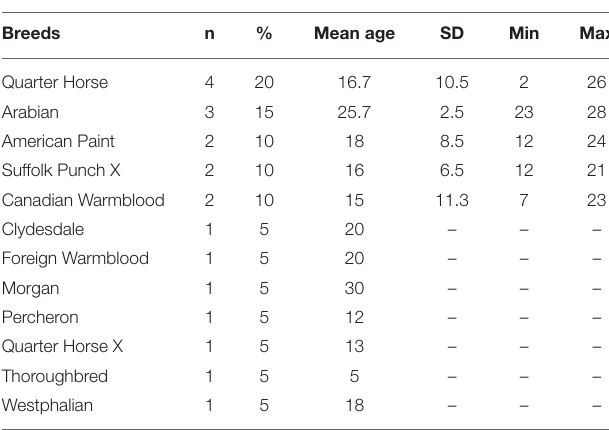
TABLE 1 | Description of the